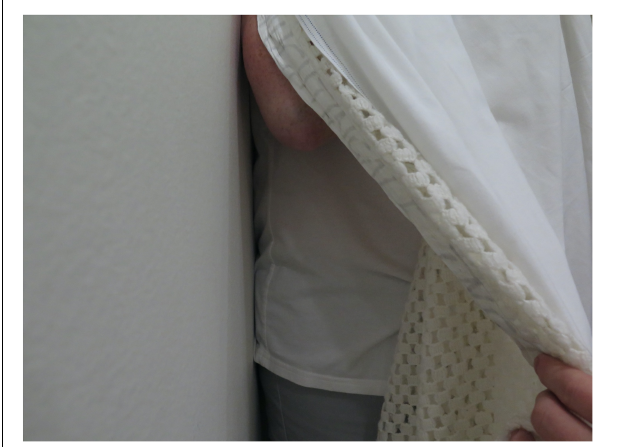
FIGURE 4 | “Seeker” trying to grab “Hider” during hide and seek game, from Hiding in Plain Sight, Becky